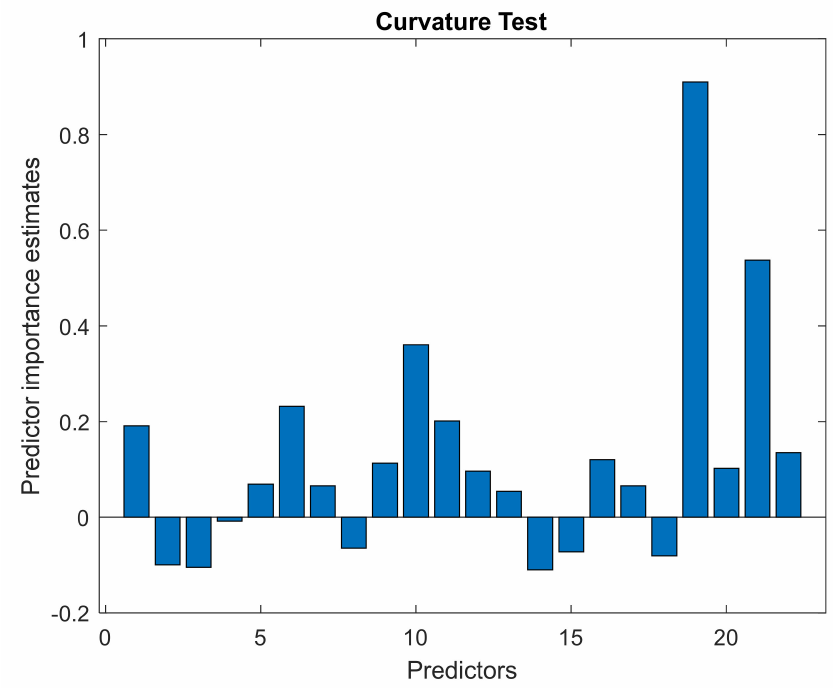
Figure A8. Contribution of individual descriptors to the development of the RF regression model for PB n . The greatest influence is shown by the descriptor no. 19, i.e., log D, besides this, the molar weight (MW) and molar volume (V) are important.